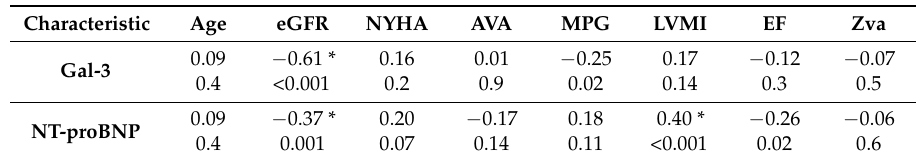
Table 3. Relations between patients’ characteristics and log-transformed plasma levels of galectin-3 (Gal-3) and N-terminal pro-B-type natriuretic peptide (NT-proBNP). Characteristic